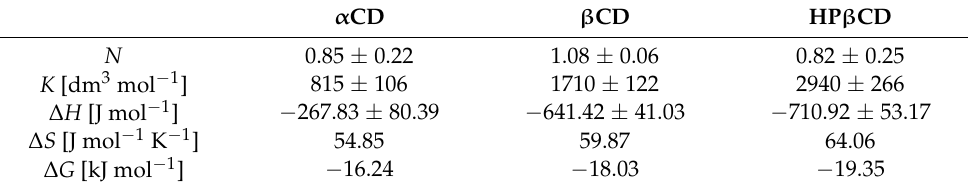
Table 1. Thermodynamic parameters of ezetimibe inclusion complexes with selected cyclodextrins.